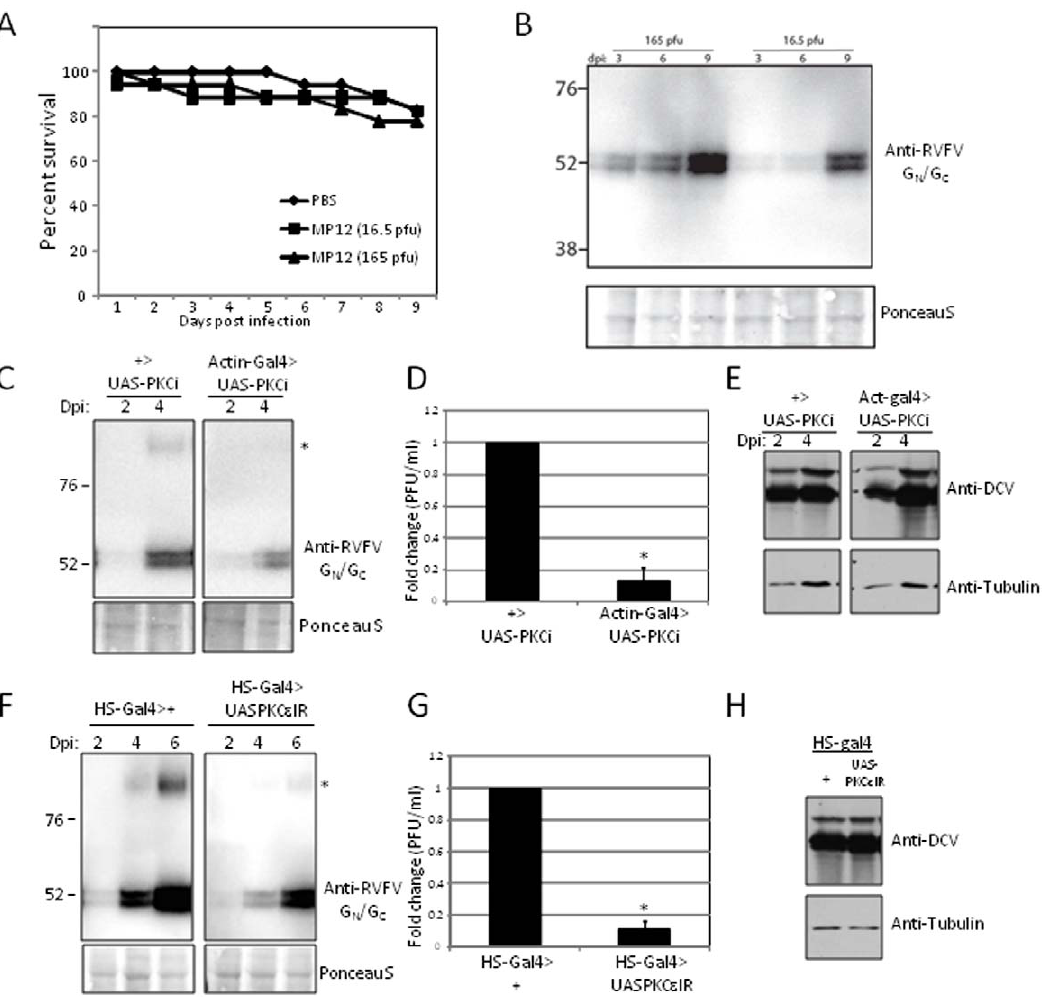
Figure 6. PKC e is required for RVFV infection in adult flies. A . RVFV MP12 infection of adult flies is non-lethal. Wild type flies (w1118) were infected with either 165pfu or 16.5pfu or vehicle control (PBS) and monitored daily for lethality. A representative experiment is shown of three independent experiments. B . RVFV infection of adult flies can be monitored by an increase in viral antigen production as a function of both dosage and time. Wild type flies were inoculated with the indicated pfu/fly and processed for immunoblot for the glycoproteins G N and G C at the indicated days post infection. A representative experiment is shown of two independent experiments. C . Adult flies over-expressing the PKC inhibitor (Actin- Gal4 . UAS PKCi) have decreased levels of viral glycoprotein production as measured by immunoblot as compared to sibling controls that do not express the inhibitors ( + . UAS PKCi). There are decreased levels of both monomers and dimers (*). A representative experiment is shown of three independent experiments. D . Adult flies over-expressing the PKC inhibitor generated and infected as in C . have decreased viral progeny production day 4 post infection compared to controls as measured by plaque assay on Vero cells. Replicate experiments are shown. E . Adult flies over-expressing the PKC inhibitor (Actin-Gal4 . UAS PKCi) have no change in the levels of Drosophila C virus infection as measured by immunoblot against the capsid proteins normalized to control. F . Adult flies depleted for the PKC epsilon isozyme (Heat Shock-Gal4 . UAS-PKC e IR) have decreased levels of viral glycoprotein production as measured by immunoblot as compared to controls that are not depleted for PKC e (Heat Shock-Gal4 . + ). There are decreased levels of both monomers and dimers (*). A representative experiment is shown of three independent experiments. G . Adult flies depleted for PKC e generated and infected as in F . have decreased viral progeny production day 4 post infection compared to controls as measured by plaque assay on Vero cells. Replicate experiments are shown. H . Adult flies depleted for the PKC epsilon isozyme (Heat Shock-Gal4 . UAS-PKC e IR) have no change in the levels of Drosophila C virus infection as measured by immunoblot compared to controls that are not depleted for PKC e (Heat Shock- Gal4 . + ).